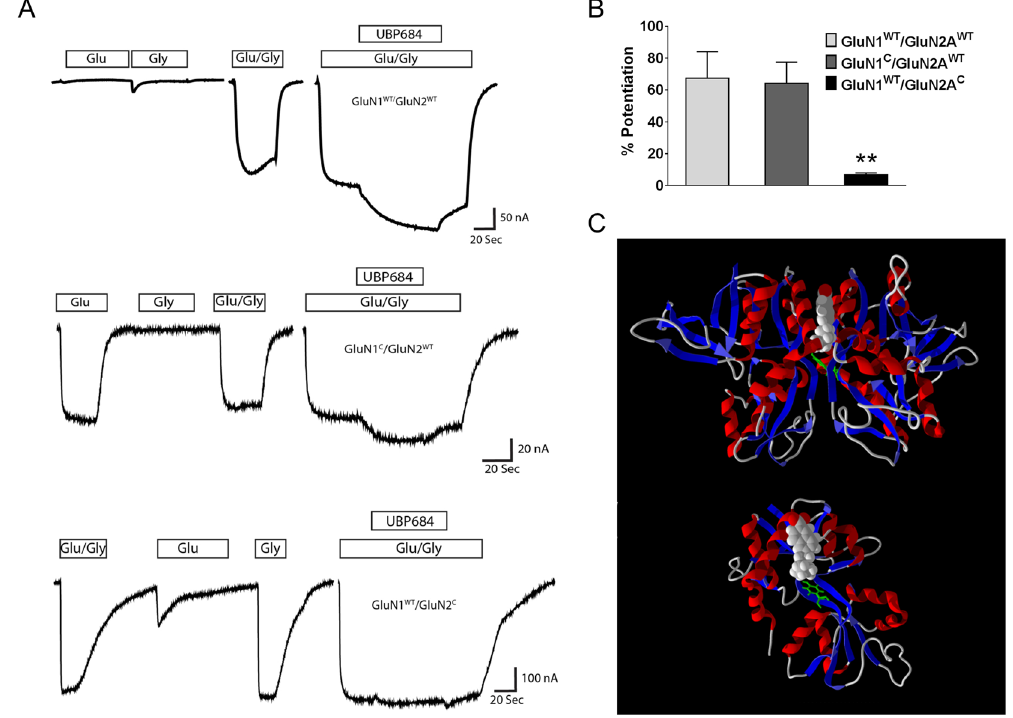
Figure 5. UBP684 potentiation is dependent on GluN2 LBD flexibility. ( A ) Current traces showing the effect of UBP684 on wildtype, GluN1 LBD-locked (GluN1 C /GluN2 WT ) or GluN2 LBD-locked (GluN1 WT /GluN2 C ) receptors. ( B ) UBP684 potentiated wildtype and GluN1 LBD-locked receptors but not GluN2 LBD-locked receptors (one-way ANOVA followed by Tukey’s test; P = 0.0012 and 0.0093 for GluN1 WT /GluN2A c compared to GluN1 WT /GluN2A WT and GluN1 C /GluN2A WT respectively; N = 19–32). ( C ) Molecular modeling of UBP684 binding to the GluN1/GluN2A receptor LBD dimer. Top: UBP684 (space filled) is shown docked into the GluN1/GluN2A LBD intersubunit interface. Modeling suggests that the carboxylic acid group of UBP684 interacts with positively charged residues on the top of the LBD away from the transmembrane domains and near the N-terminal domains. The alkyl side chain terminates near the LBD hinge region near GluN1 Y535 shown in green. Bottom: The same docking of UBP684 is shown rotated 90° in the horizontal plane with the GluN1 LBD removed and GluN1’s Y535 shown for